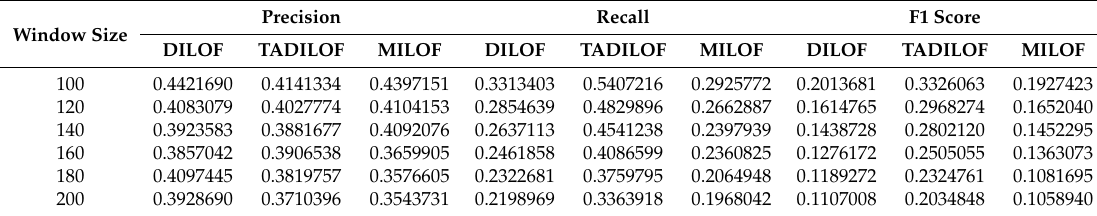
Table 6. Precision, recall, and F1 score on Musk dataset.